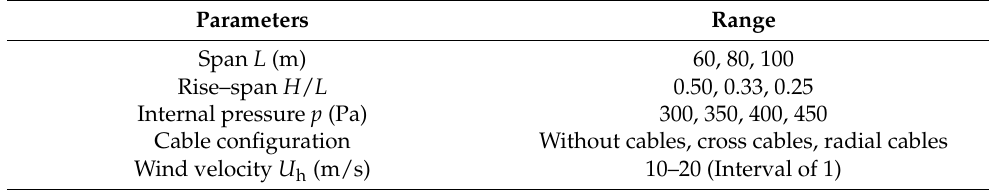
Table 4. The parameters of all cases.